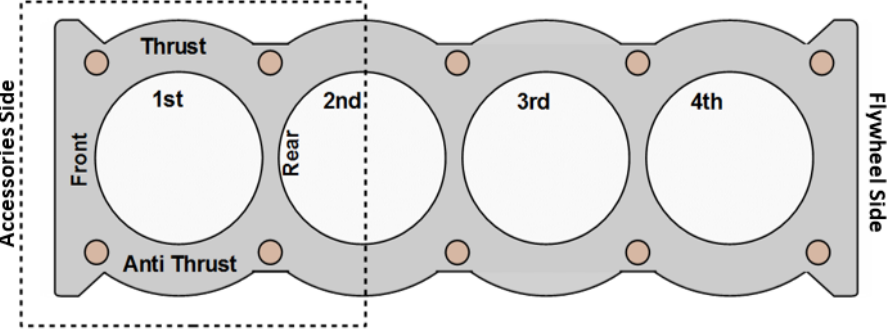
Figure 1. One and a half cylinder model used in this study with the different sides of the cylinder.